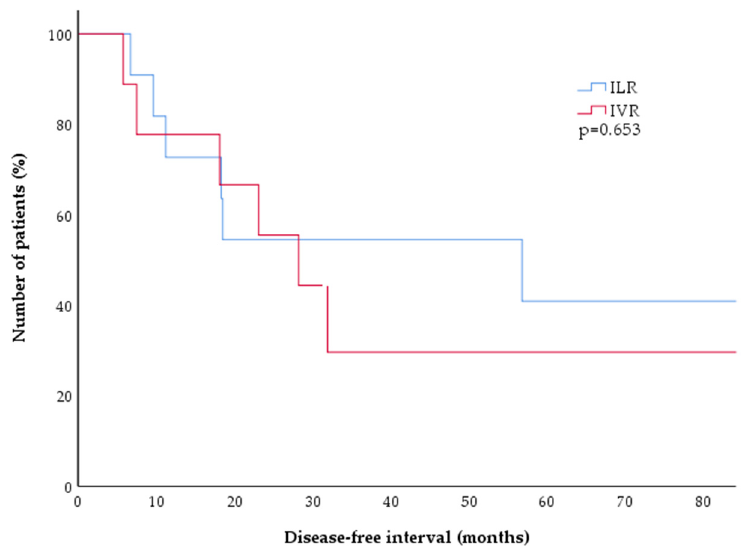
Figure 2. Kaplan–Meier estimates of disease-free survival after treatment of CBCL with either ILR (blue) or IVR (red). There was no significant difference between both treatment arms, with 50% of patients experiencing a relapse after approximately two years ( p = 0.653). CBCL = cutaneous B-cell lymphoma; ILR = intralesional rituximab; IVR = intravenous